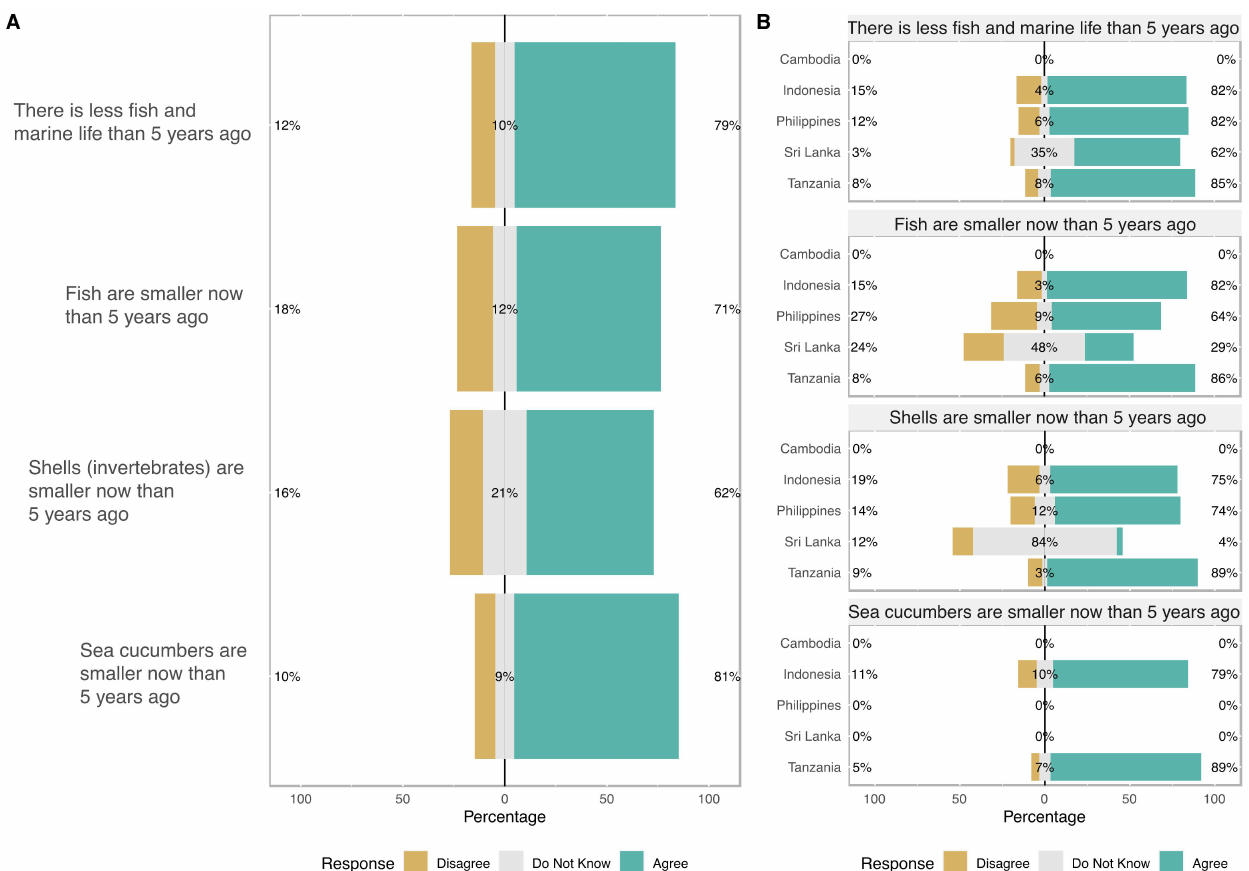
Figure 3. Consensus statements related to five-year changes (number and size) in faunal communities (fish and invertebrates) in the Indo-Pacific region: ( A ) across the whole dataset; ( B ) across each country. Respondents were presented four statements and responses could be categorised as either “agree”, “disagree”, or “do not know”. The numbers represent the proportion of respondents within each